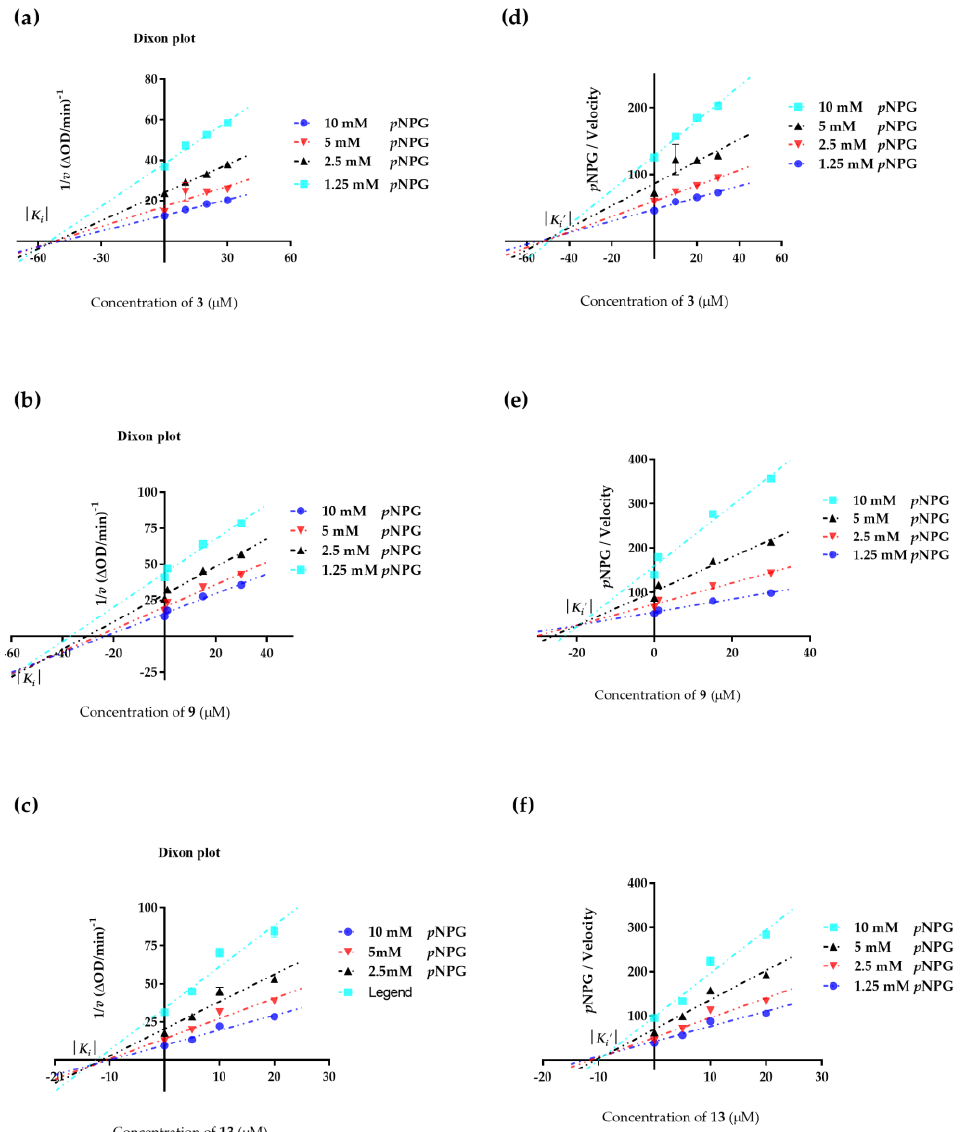
Figure 8. Determination of K i and K i ’ of compounds 3 , 9 , and 13 on α -glucosidase. ( a ) 1/ v − [I] fitting curve of compound 3 . ( b ) 1/ v − [I] fitting curve of compound 9 . ( c ) 1/ v − [I] fitting curve of compound 13 . ( d ) [ p NPG]/ v − [I] fitting curve of compound 3 . ( e ) [ p NPG]/ v − [I] fitting curve of compound 9 . ( f ) [ p NPG]/ v − [I] fitting curve of compound 13 . All values are mean ± SD from at least three independent experiments.